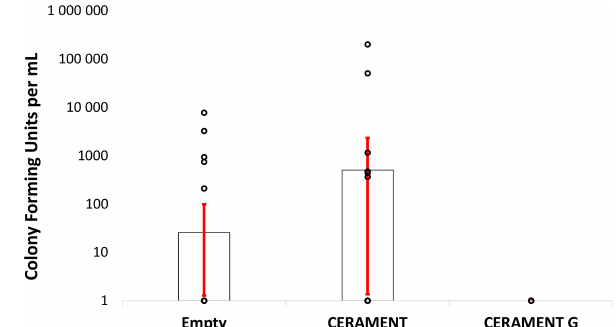
Figure 4. Bacterial counts: colony forming units per milliliter of sonicate taken from empty, CERAMENT Bone Void Filler, and CE- RAMENT G groups ( n = 20 per group). Bacterial quantities were not significantly different between treatment groups owing to the large standard deviations of the non-CERAMENT G groups. Error bars represent ± 1standard